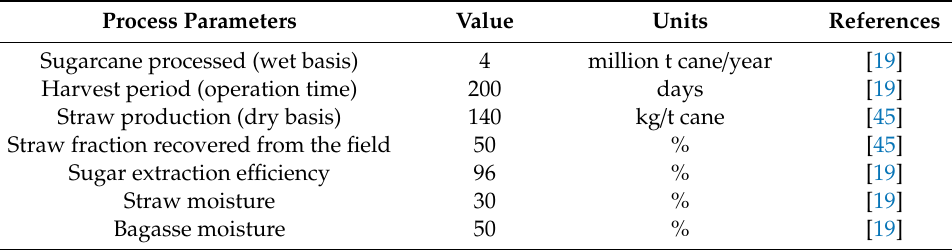
Table A3. Processing capacity adopted in the simulations.